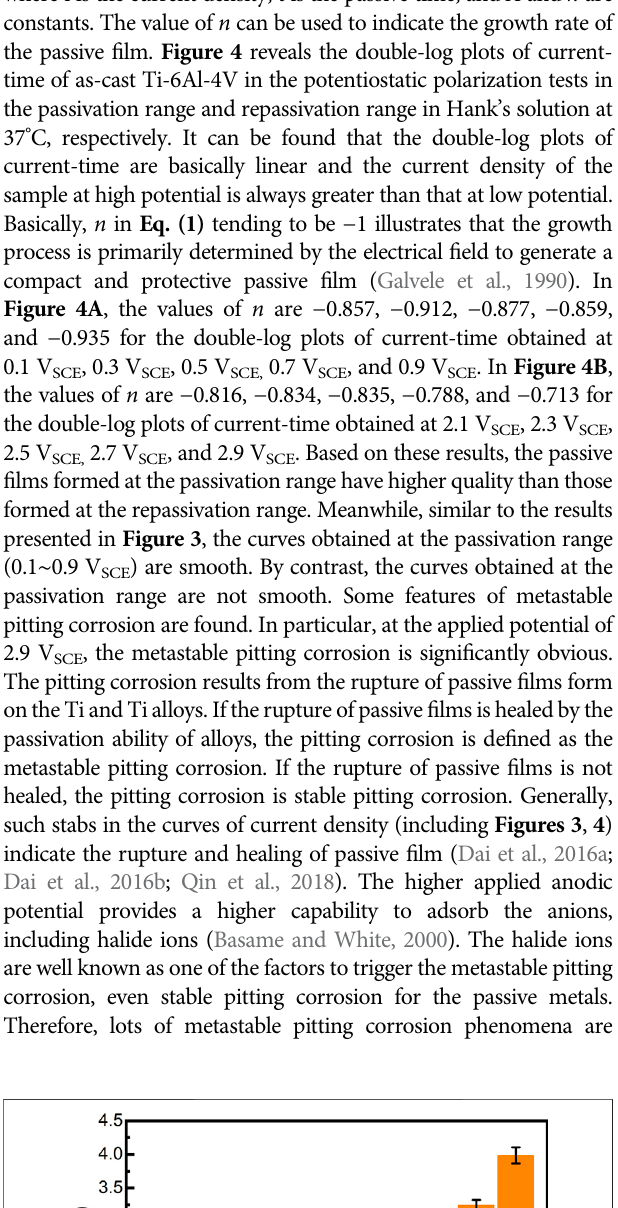
Frontiers in Materials |